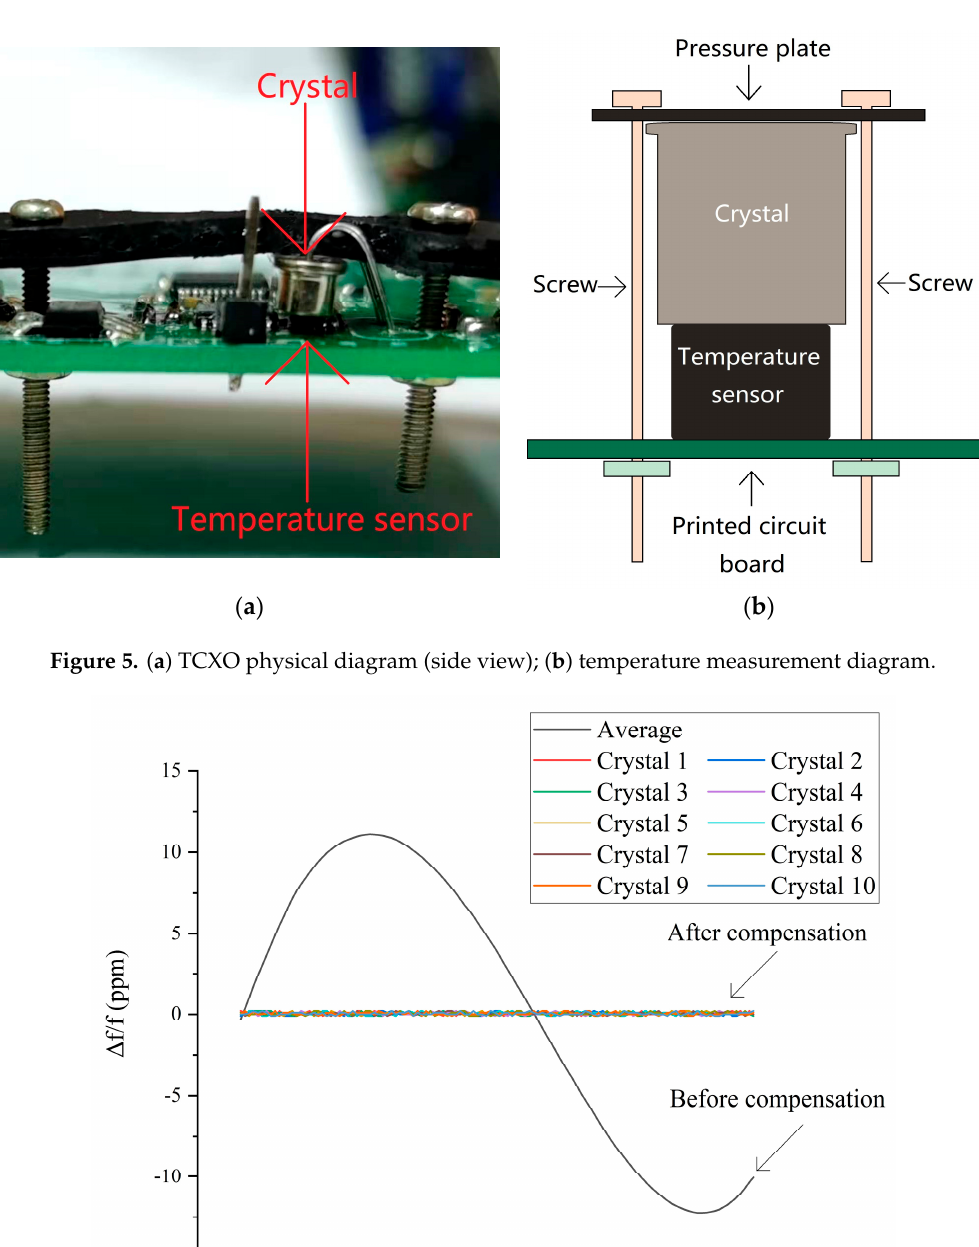
Figure 5. ( a ) TCXO physical diagram (side view); ( b ) temperature measurement diagram.